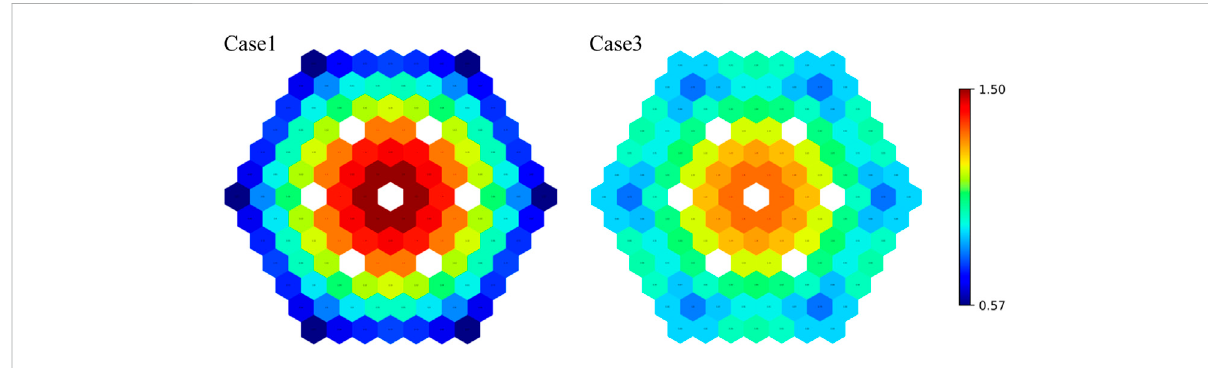
FIGURE 5 Assembly power distribution results on the beginning of life of the re fl ector amount